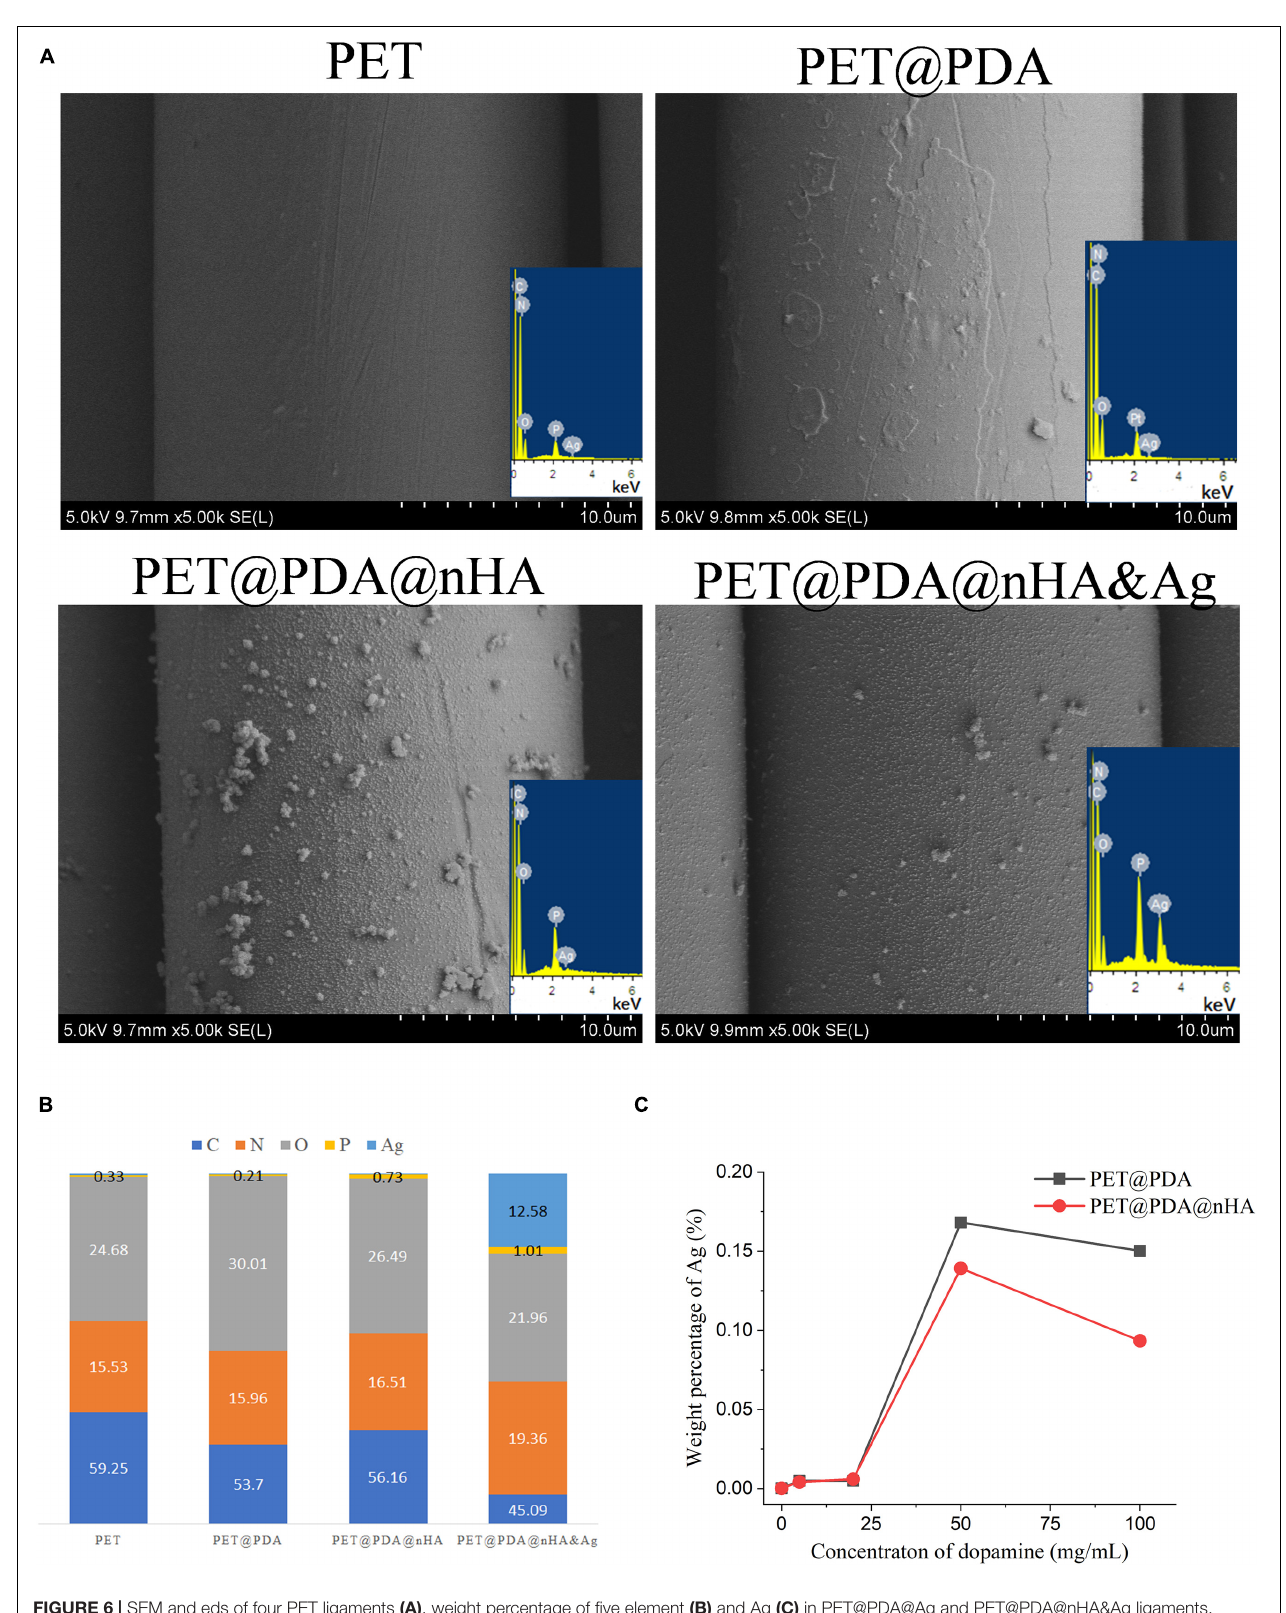
Frontiers in Bioengineering and Biotechnology |